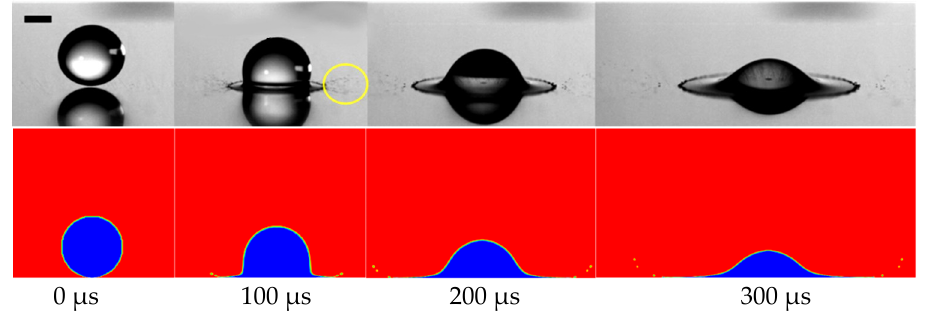
Figure 4. Comparison between simulated results and experimental results.